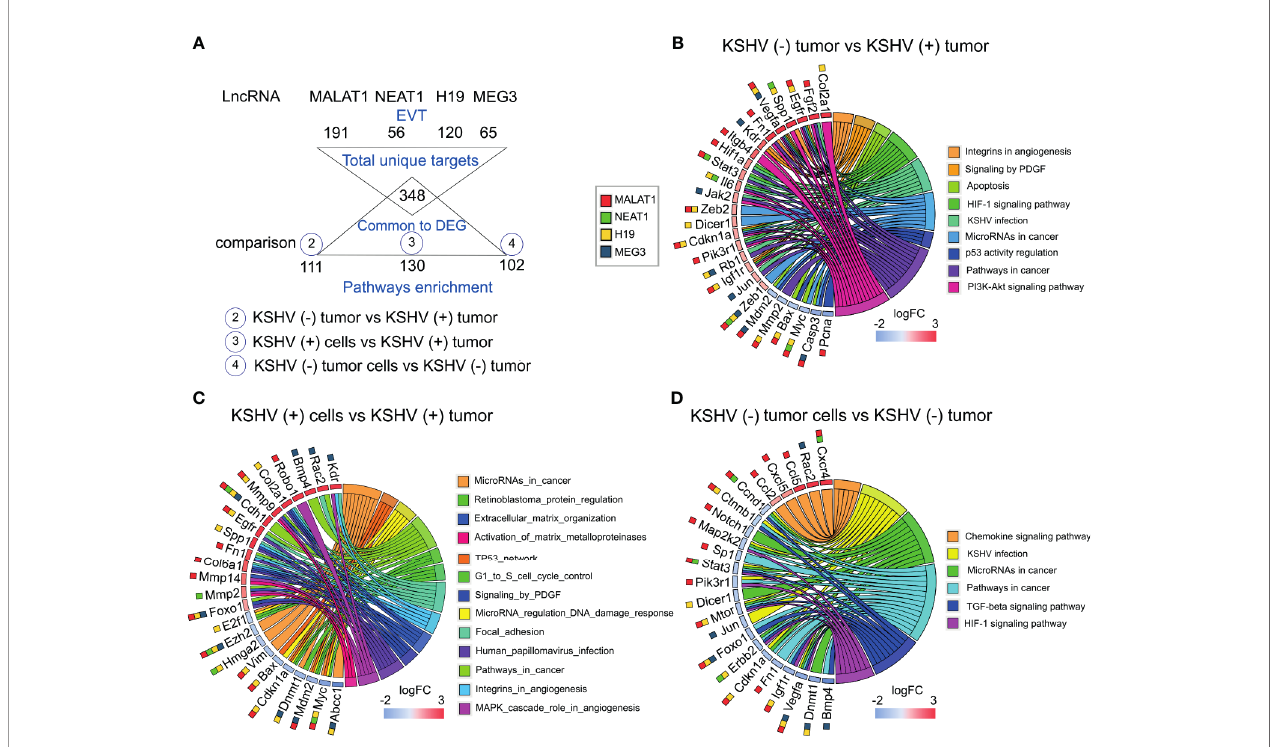
FIGURE 3 | Pathway analysis of selected DE lncRNAs and their EVT genes. (A) Schematic representation of the EVT genes of Malat1, Neat1, H19 and Meg3 that were correlated with gene expression in the RNA-sequencing analysis. (B – D) Chord plot illustrating the GO biological process terms and the target genes contributing to that enrichment arranged in order of their expression level in KSHV ( − ) tumors versus KSHV (+) tumors (B) , KSHV (+) cells versus KSHV (+) tumors (C) and KSHV ( − ) tumor cells versus KSHV ( − ) tumors (D) . The corresponding lncRNAs are indicated with color boxes besides each target